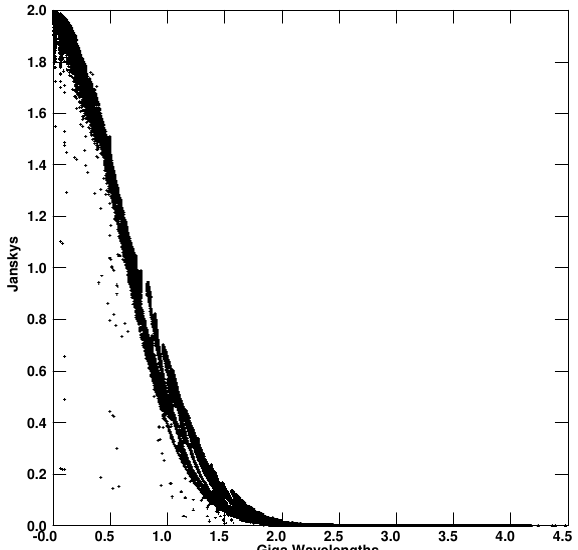
Figure 7. Visibility amplitude for the simulations as a function of uv distance for observations of SgrA* at 115 GHz. The model used in ARIS was a Gaussian based on the results of [18]. showing that significant flux ( > 0.1Jy) is detectable out to 1.5 G λ , corresponding to ∼ 4000km. This clearly shows why the baseline lengths need to be < 1.5 G λ , and a two step calibration (hub-to-spoke and facet-to-global solutions) is